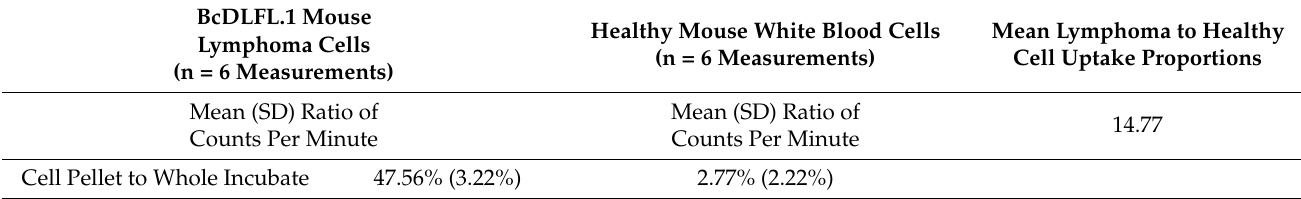
Table 1. Mouse lymphoma cell and healthy mixed mouse leukocyte [18F]FDG uptake differences. Bc.DLFL1 lymphoma cells have a significantly higher capacity to take up FDG over normal mouse leukocytes. BcDLFL.1